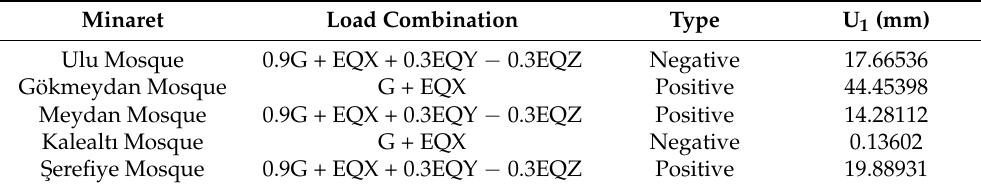
Table 9. Maximum displacements of Five Minarets in Ux direction.